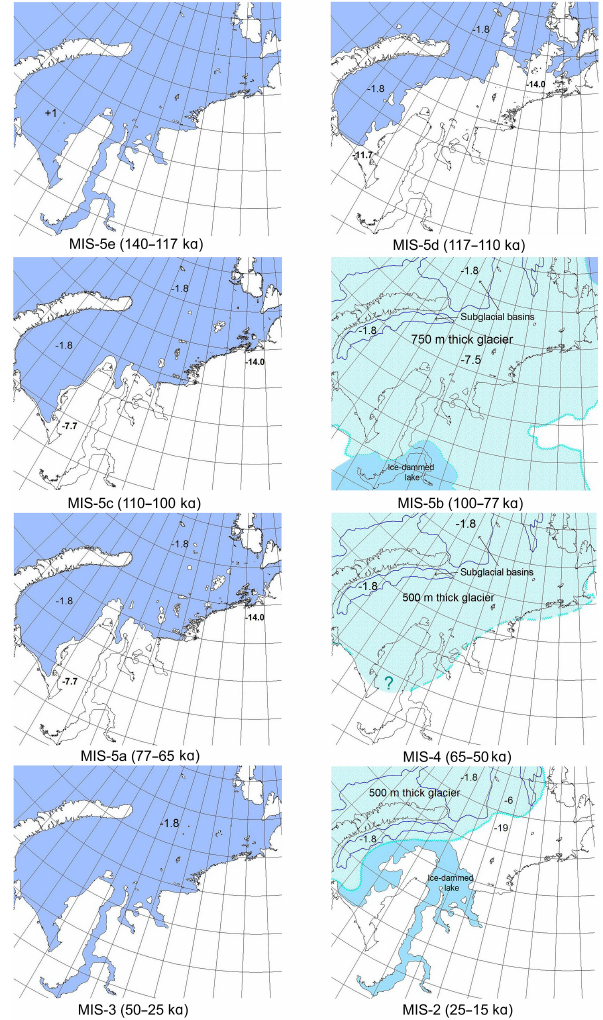
Figure 7. The series of cartographic schemes illustrating the change in surface conditions on the Kara Sea shelf for the following mo- ments: MIS-5e (140–117ka); MIS-5d (117–110ka); MIS-5c (110–